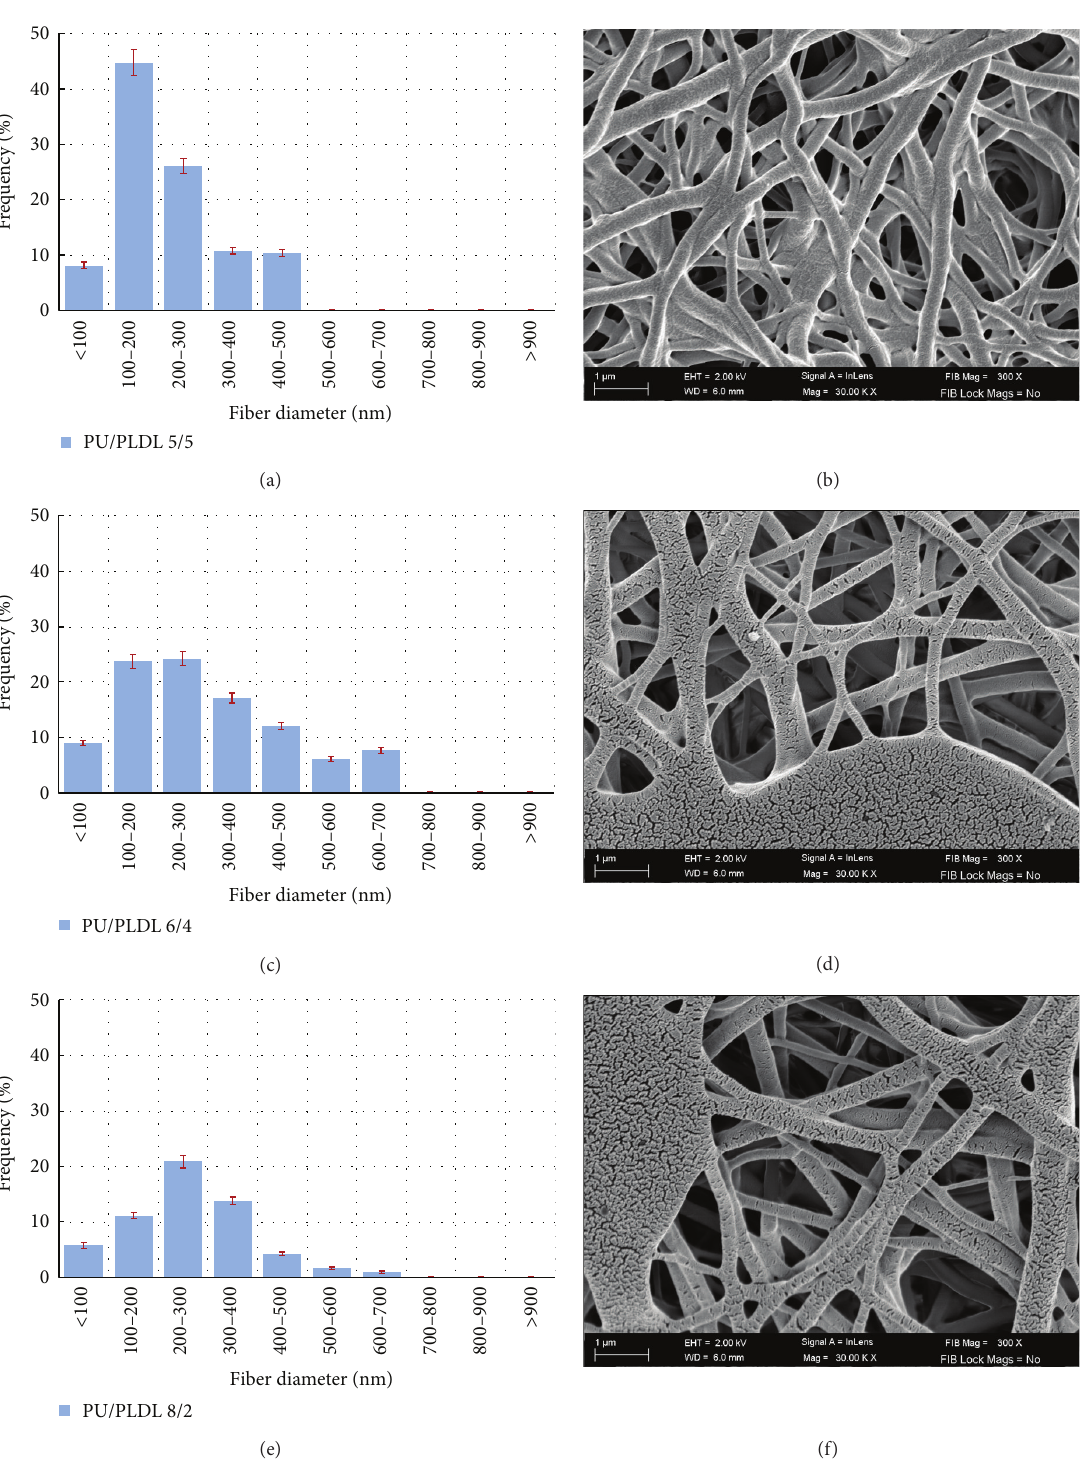
Figure 1: SEM micrographs of PU/PLDL nonwovens (right) and bar graphs (left) displaying fiber diameters. Weight ratios of PU/PLDL: (a, b) 5/5, (c, d) 6/4, and (e, f) 8/2. Thickness of the fibers depends on the blend composition; that is, the more PU in the blend the thicker and more regular the fibers. Some beads are created along the fibers; however, they were not taken into consideration in the average diameter